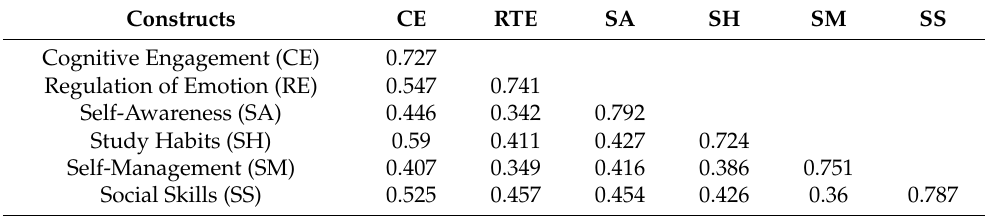
Table 2. Discriminant validity